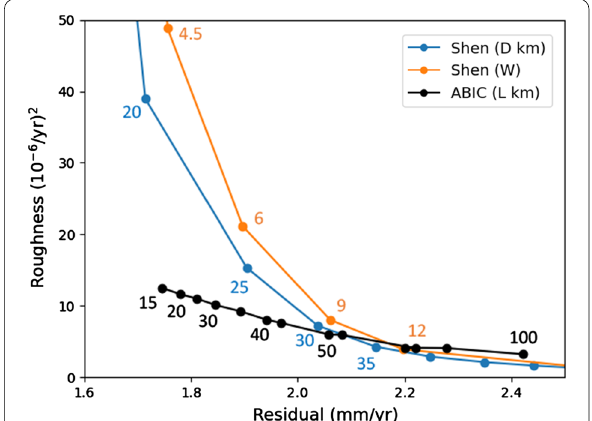
Fig. 11 Trade-off curve between residual and roughness. The root-mean squares (RMS) of fitting errors (residual) and roughness (Eq. 14) of the velocity field are plotted. The lower left area corresponds to good models. Blue and orange curves represent the results of Shen’s method with different D (km) and W , respectively (the value is attached at each point). The black curve represents the results of the ABIC method; attached numbers represent the basis-function interval L